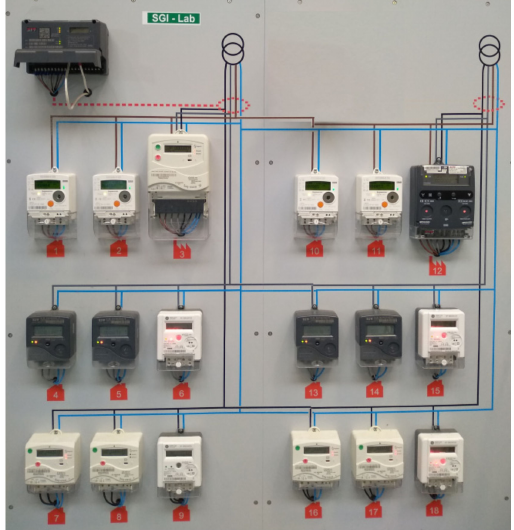
Figure 5. Testbed used for evaluating the data concentrator-smart meters